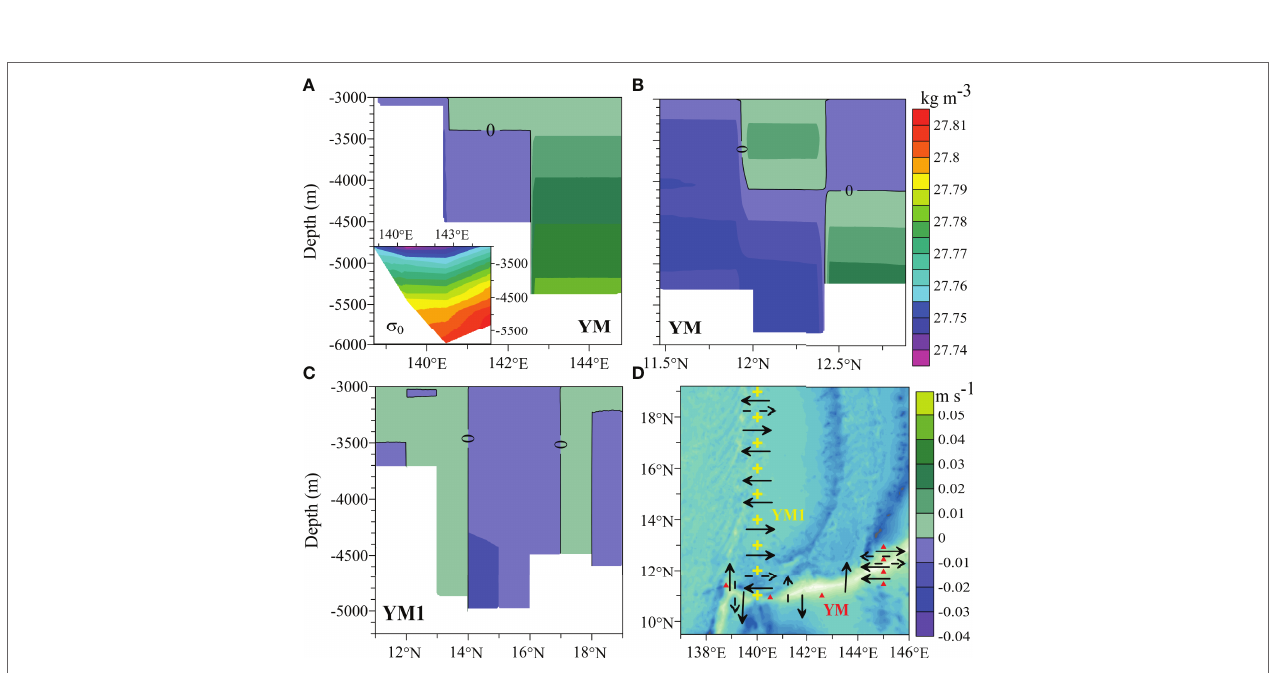
FIGURE 5 | Meridional flows and potential density σ 0 at section YM along Yap-Mariana Junction channels (A) , zonal flows across Mariana Trench (B) , zonal flows at section YM1 along 140°E in a part of the Mariana Trench and the West Mariana Basin (C) , and the schematic of flows in the junction region (D) . Dashed arrow lines denote upper abyssal